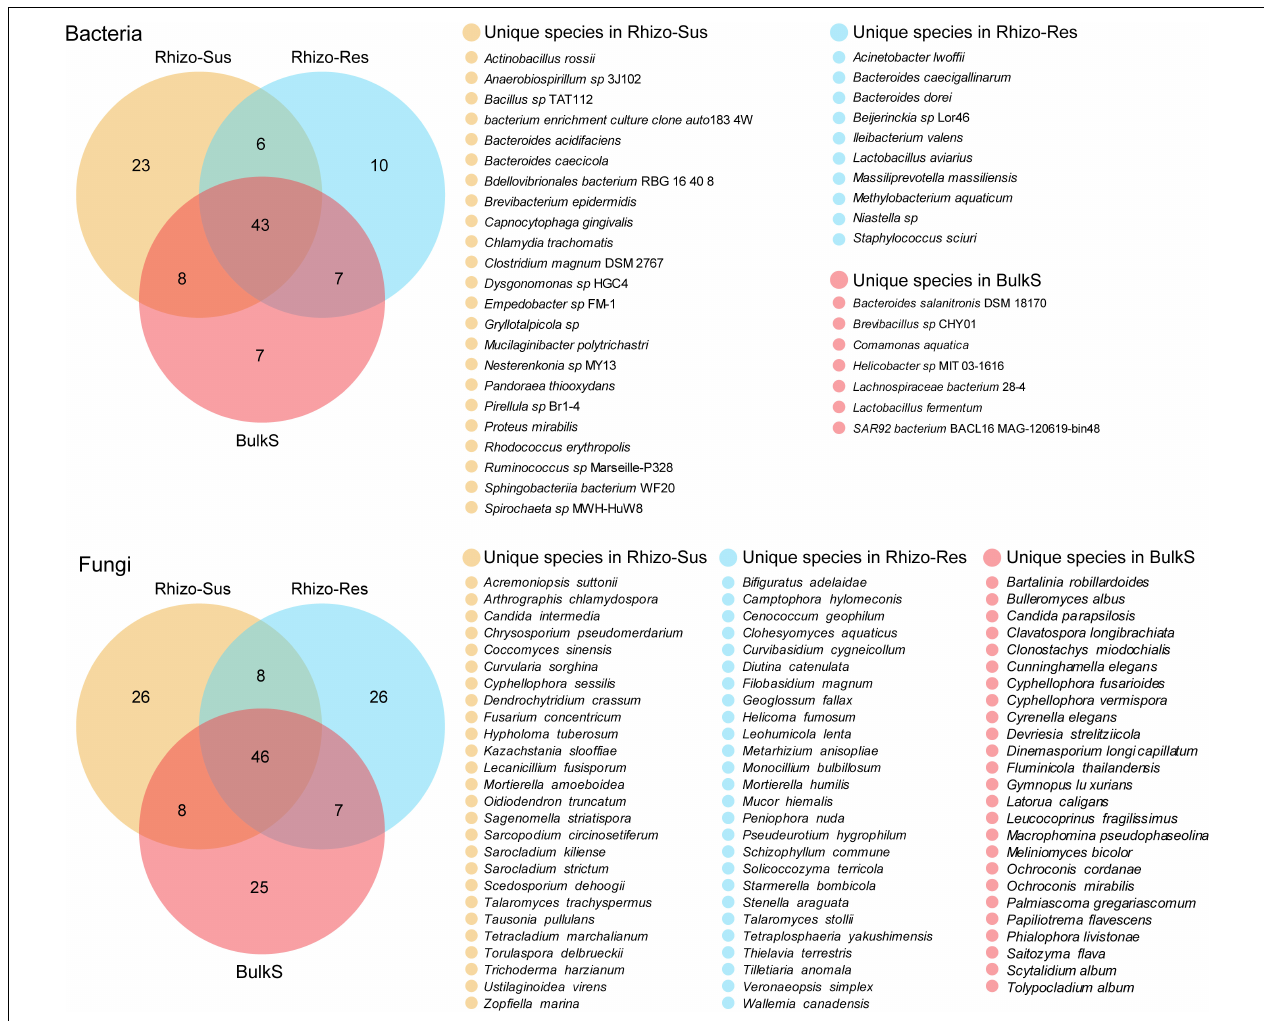
FIGURE 4 | Venn diagram of bacteria and fungi at species level among C. oleifera rhizosphere (Rhizo-Sus), C. yuhsienensis rhizosphere (Rhizo-Res), and bulk soil (BulkS), N = 12. Yellow, blue, and red color indicate the unique species that are only presented in Rhizo-Sus, Rhizo-Res, or BulkS, respectively. The cross-color block indicates the shared species between Rhizo-Sus and Rhizo-Res, or Rhizo-Sus and BulkS, or Rhizo-Res and BulkS, or among Rhizo-Sus, Rhizo-Res, and BulkS. The quantity of unique and shared species was written in each color block of Venn diagram,